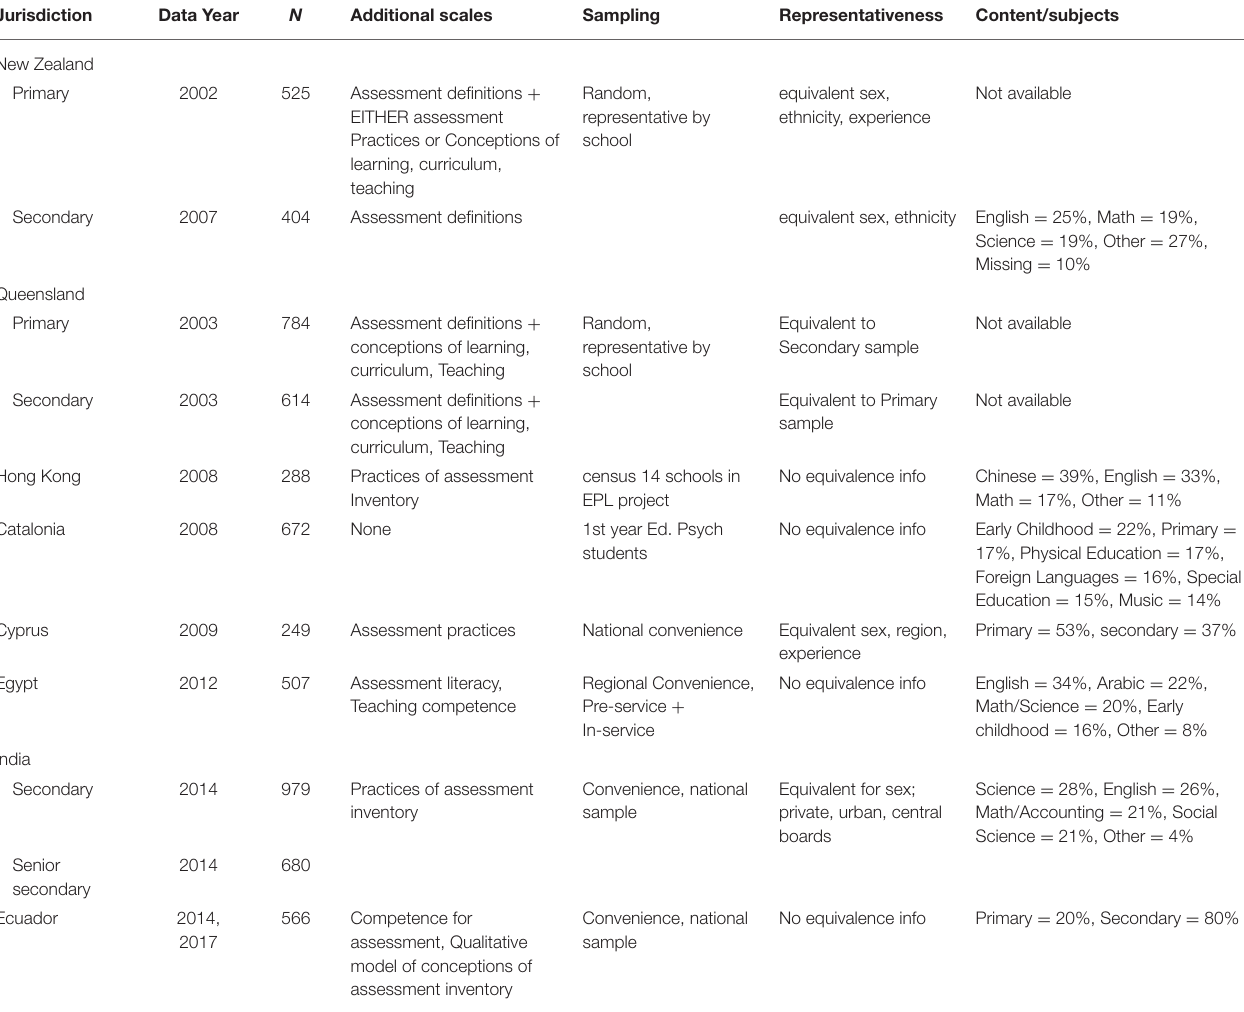
TABLE 1 | Participant characteristics by